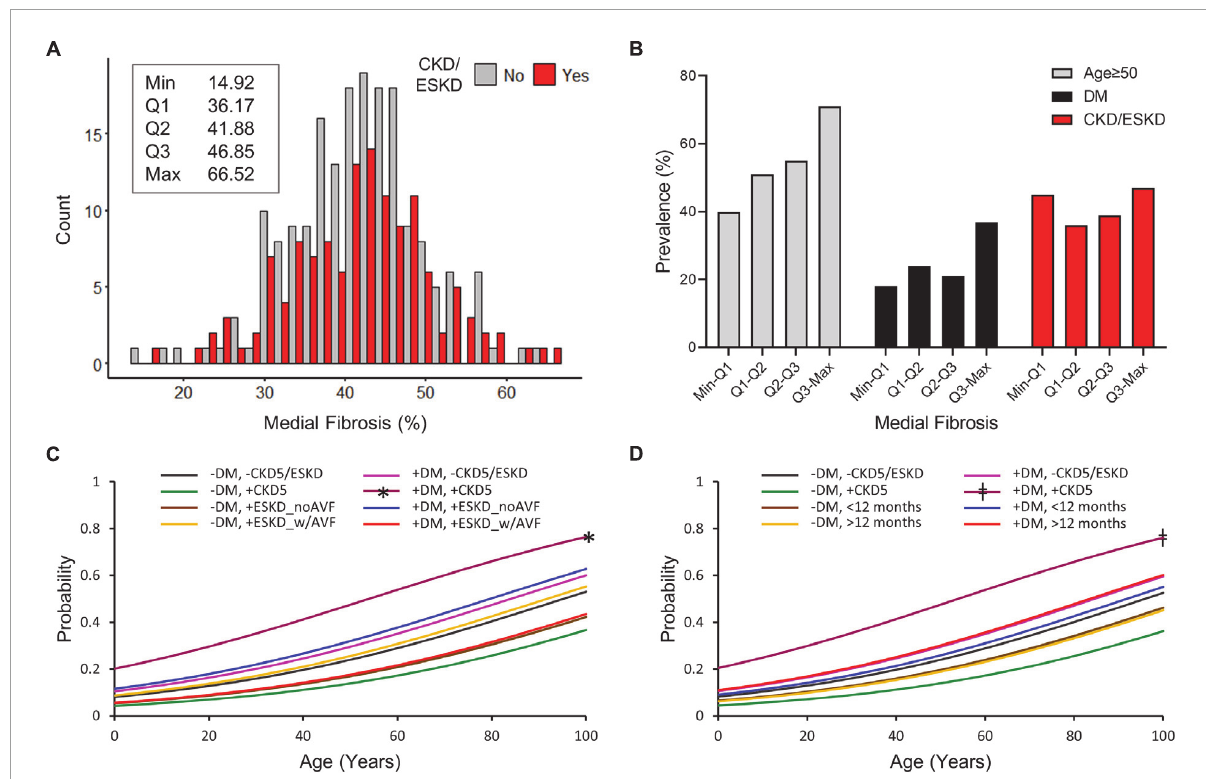
FIGURE2 Predictors of high medial fibrosis in CKD and non-CKD veins. (A) Histogram of percent medial fibrosis in CKD/ESKD and non-CKD veins. The minimum, first quartile (Q1), median (Q2), third quartile (Q3), and maximum values are indicated for the overall study cohort. (B) Prevalence of age ≥ 50 years, diabetes, and CKD/ESKD per quartile of medial fibrosis in the overall study cohort. (C,D) Probability of medial fibrosis falling in the upper quartile values ( ≥ 46.85%) as predicted by age and combined status of diabetes and CKD/ESKD stages. CKD subgroups are separated according to disease stage and vascular access history (C) or dialysis vintage (D) . DM, diabetes; CKD5, stage 5 CKD; ESKD_noAVF, ESKD without previous AVF or AVG; ESKD_w/AVF, ESKD and previous AVF/AVG history. ∗ p < 0.05 vs. (–) DM/(+) CKD5 and (–) DM/(+) ESKD_noAVF, ‡ p < 0.05 vs. (–) DM/(+)CKD5 and (–) DM/ < 12